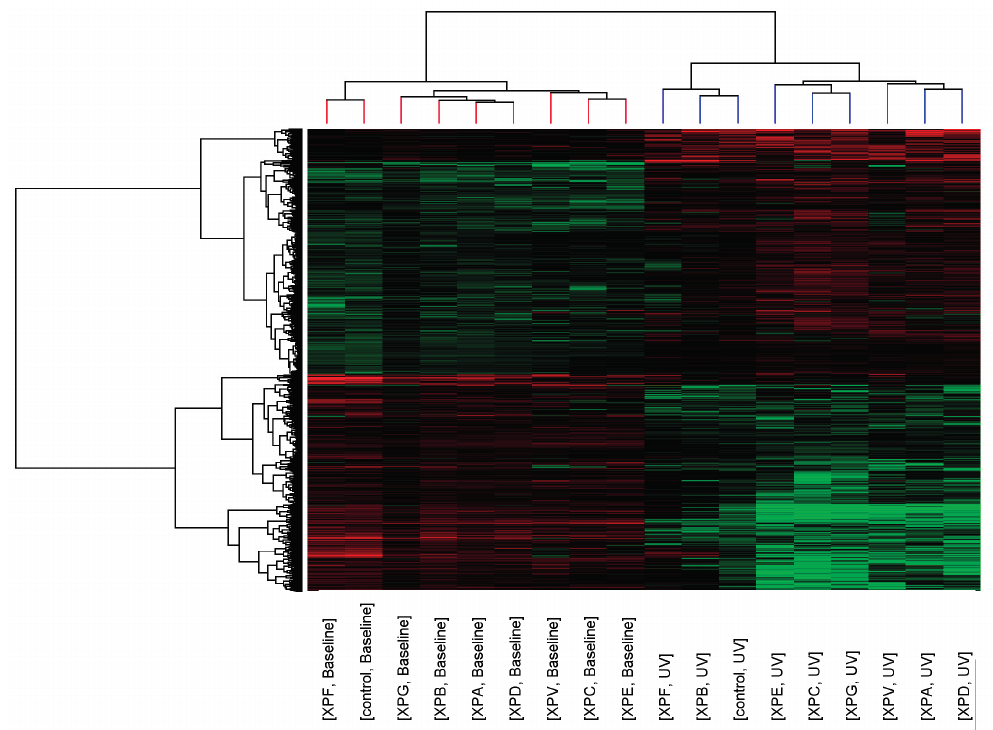
Figure 1. Cluster analysis of control and XP complementation groups before and after UVC-light. Each column represents average transcript expression for duplicate cell lines for control and each of the XP complementation groups before and after 2 J/m 2 UVC-light exposure. Down-regulation is represented as green, up-regulation as red and normal expression as black. The dendrogram represents the relationship between and within the controls and XP complementation